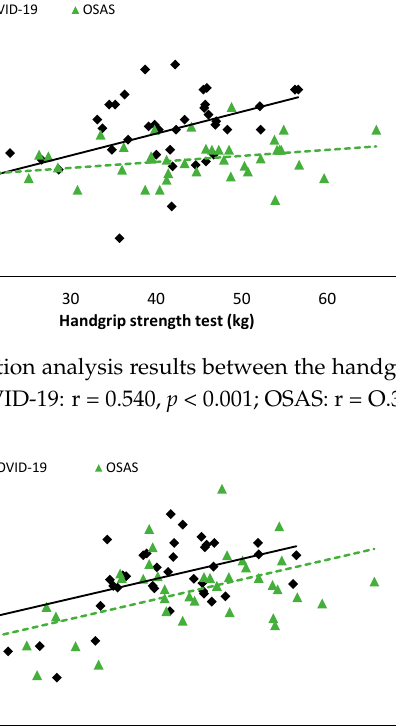
Figure 3. Oxygen saturation alteration during the 6 min walk (6MWT) test between the groups. # <0.005, ‡ <0.001.